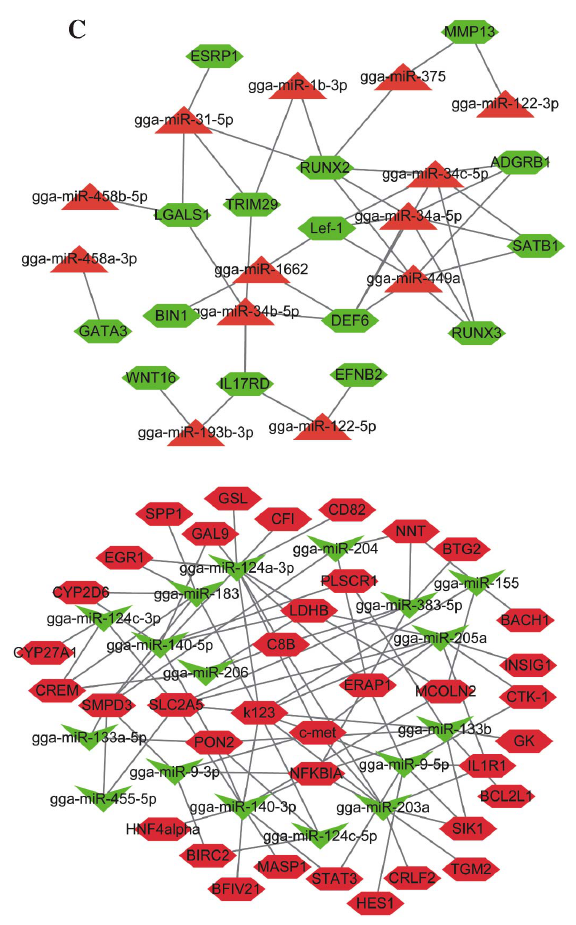
Figure 4. Conjoint analysis of small RNA ‐ seq and RNA ‐ seq in chicken embryos infected with NDV. ( A ) Flow diagram of the conjoint analysis of small RNA ‐ seq and RNA ‐ seq. ( B ) Venn analysis of the predicted miRNA target mRNAs and the differentially expressed mRNAs with the same expression trend in both the F48E9 and La Sota infections. The left panel shows the common highly expressed mRNAs, and the right panel shows the common lowly expressed mRNAs. ( C ) miRNA–mRNA interaction networks in NDV ‐ infected chicken embryonic tissues. The top panel shows the miRNA–mRNA network of the upregulated miRNAs and downregulated mRNAs, and the bottom panel shows the miRNA–mRNA network of the downregulated miRNAs and upregulated mRNAs.